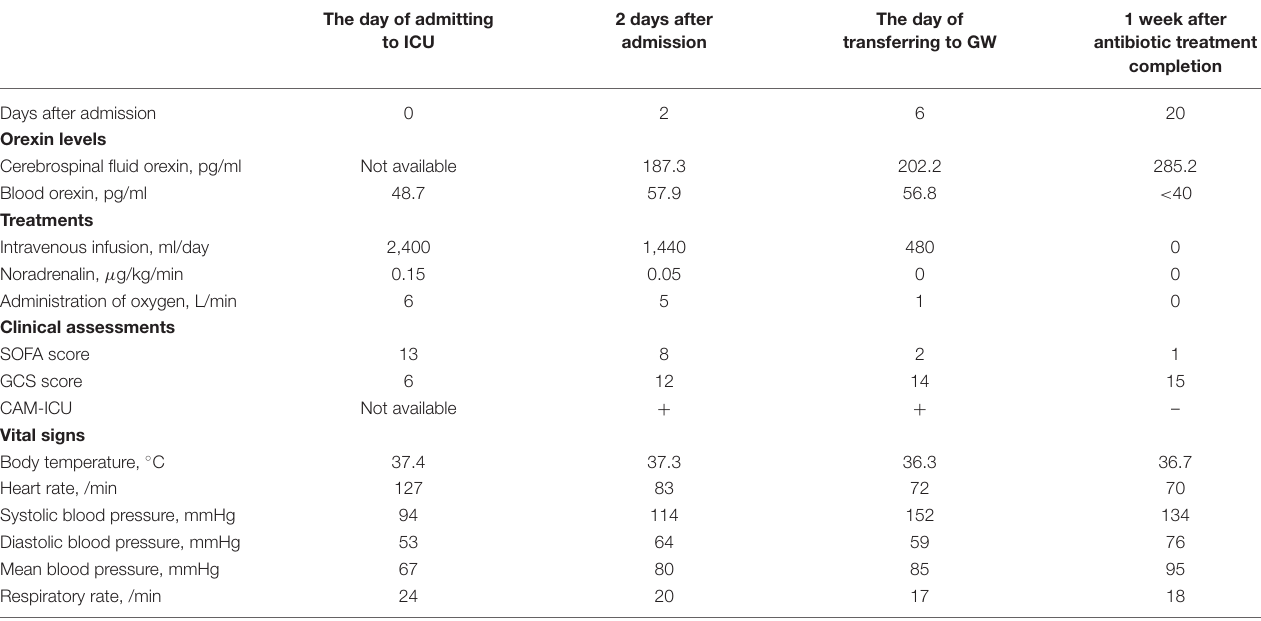
TABLE 1 | Orexin levels, treatment, and clinical data.